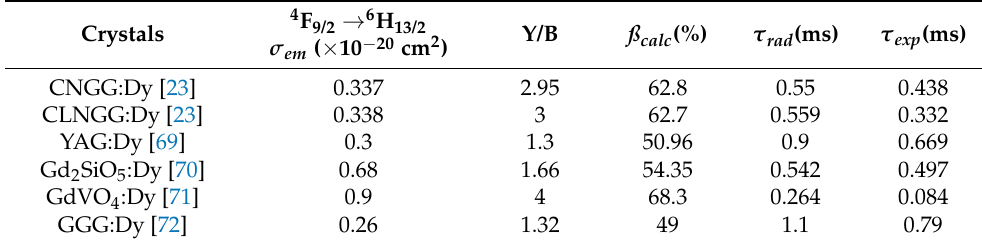
Figure 8. Emission spectra of Dy 3+ ions in CNGG:Dy ( a ) and CLNGG:Dy ( b ) crystals at room temperature. (Reprinted with permission from Ref. [23], copyright 2018, Elsevier). Table 8. Emission cross sections ( σ em ), branching ratios (β JJ’ ) , and Y/B (yellow/blue) ratio of the yel- low transition of Dy 3+ ions in CNGG:Dy and CLNGG:Dy compared with other materials. (Reprinted with permission from Ref. [23], copyright 2018, Elsevier).